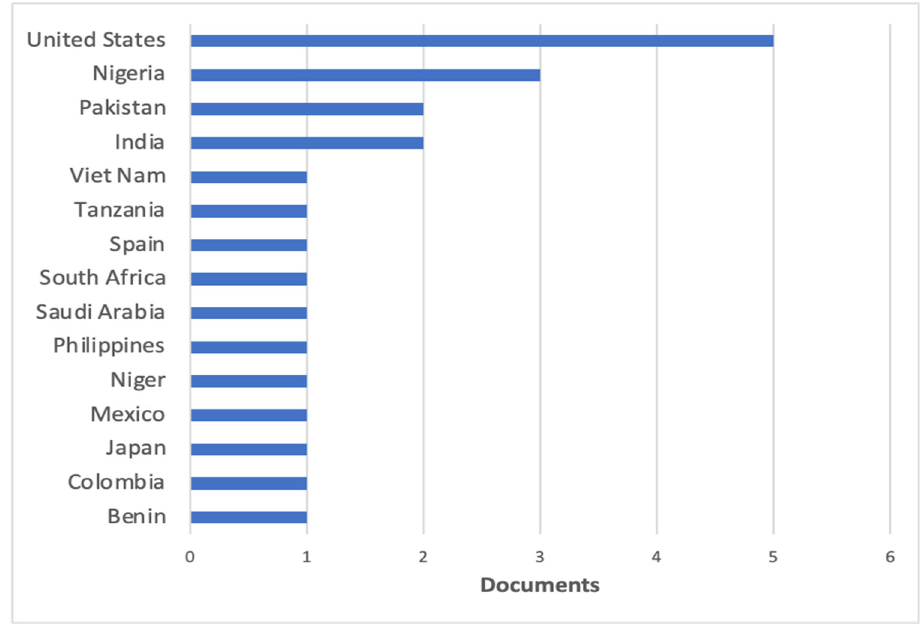
Figure 2. Publications by country or territory.